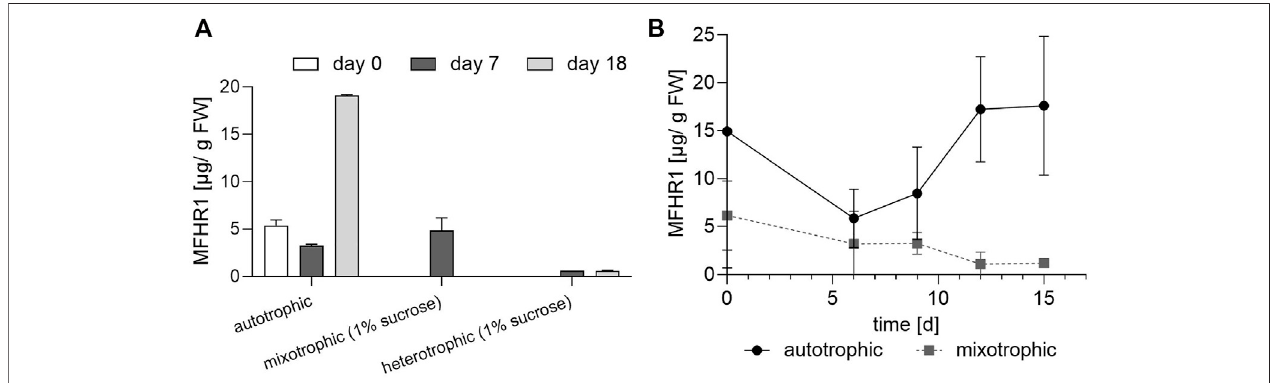
FIGURE 4 | Mixotrophic and heterotrophic conditions negatively affect the production of MFHR1 (A) Speci fi c MFHR1 productivity at shaken- fl ask scale under autotrophic (50 – 70 µmol/m 2 s light, photoperiod 16/8), mixotrophic (1% sucrose and 50 – 70 µmol/m 2 s light, photoperiod 16/8), and heterotrophic conditions (1% sucroseanddarkness)atday7and14(transgeniclineA). (B) ProductionkineticsofMFHR1underautotrophicandmixotrophicconditions(1%glucose)inmosslineAat shaken- fl ask scale. Data represent mean values ±SD from three biological replicates.